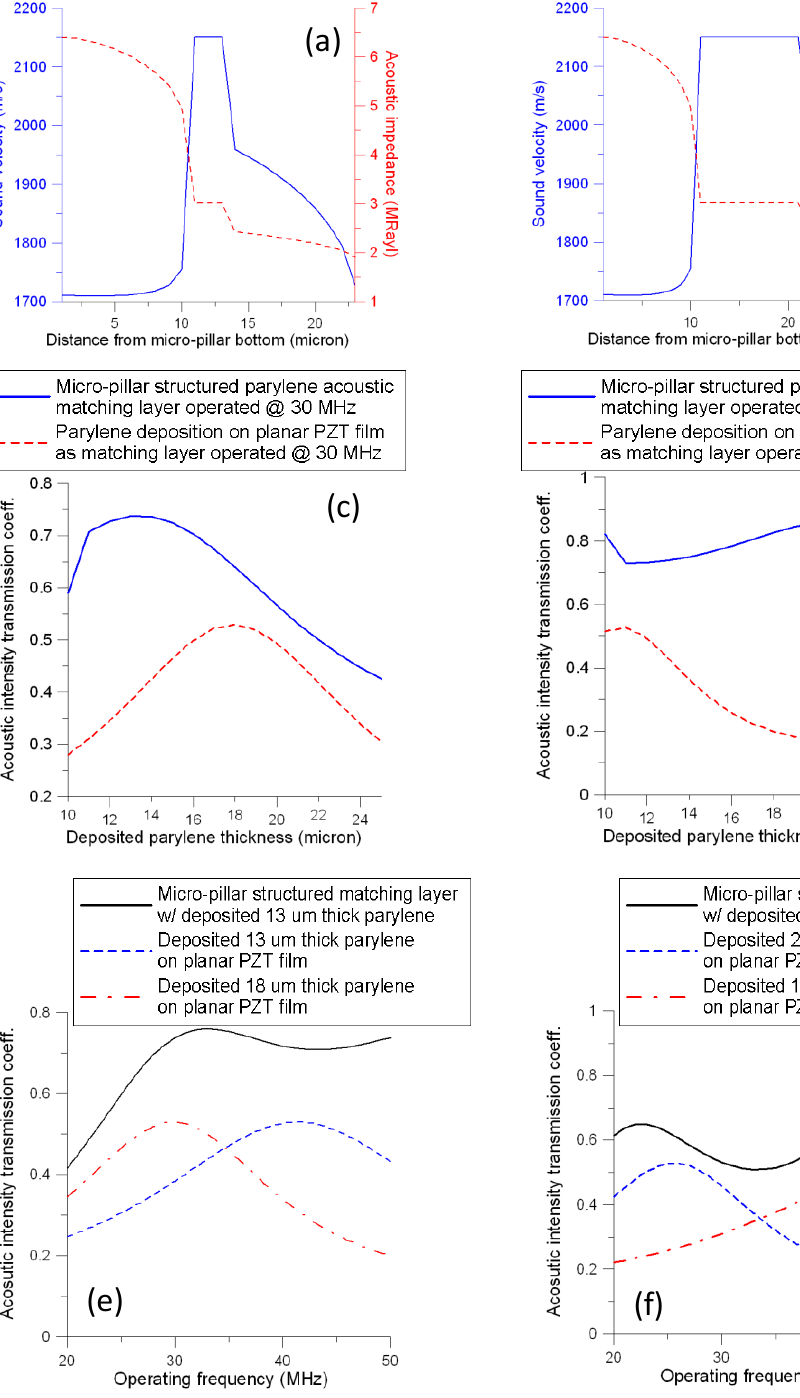
Figure 3. Numerical results: ( a , b ) sound velocity/acoustic impedance as the function of the distance from the bottom of designed micropillar outward for two different cases of 13 and 21 μm Parylene deposition, respectively (Figure 2); ( c , d ) Comparison of the acoustic intensity transmission coefficients of the PZT micropillar structured and simply planar PZT structured matching layer with varied parylene thicknesses; ( e , f ) Frequency responses of the acoustic intensity transmission coefficients based on the given thickness of Parylene